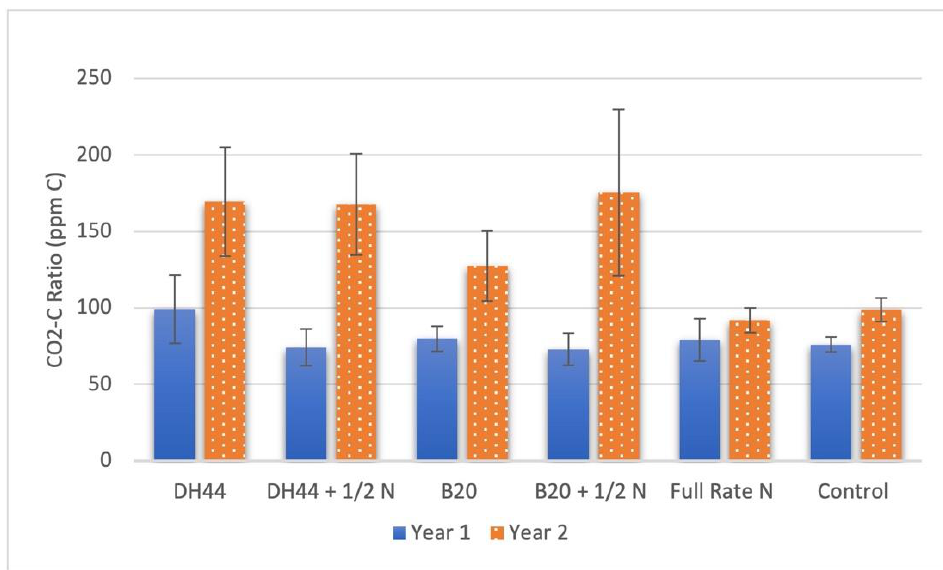
Figure 2. Mean soil microbial respiration (CO 2 -C ratio) in bermudagrass plots treated with conven- tional fertilizer or biofertilization. Treatments included rhizobacterial inoculants (DH44 and B20) and those rhizobacteria applied with 56 kg N/ha (1/2 N). Treatments were compared to a full rate of nitrogen fertilizer (112 kg N/ha) as a positive control and a non-treated, negative control. Respiration rates for PGPR plots in 2021 were significantly higher than in 2020. ( p <